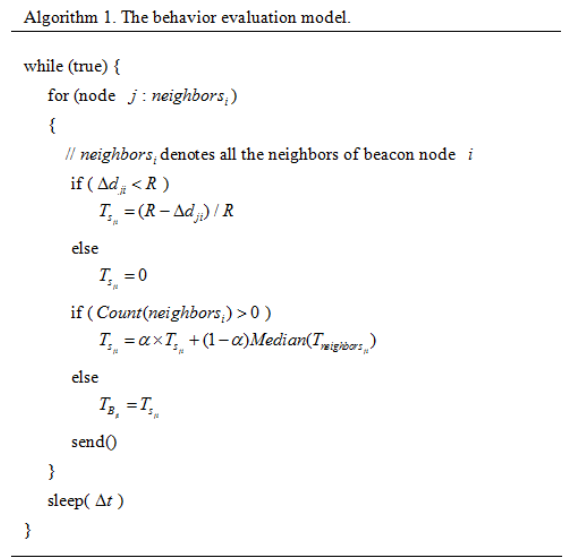
Fig.3. Algorithm for the behavior evaluation